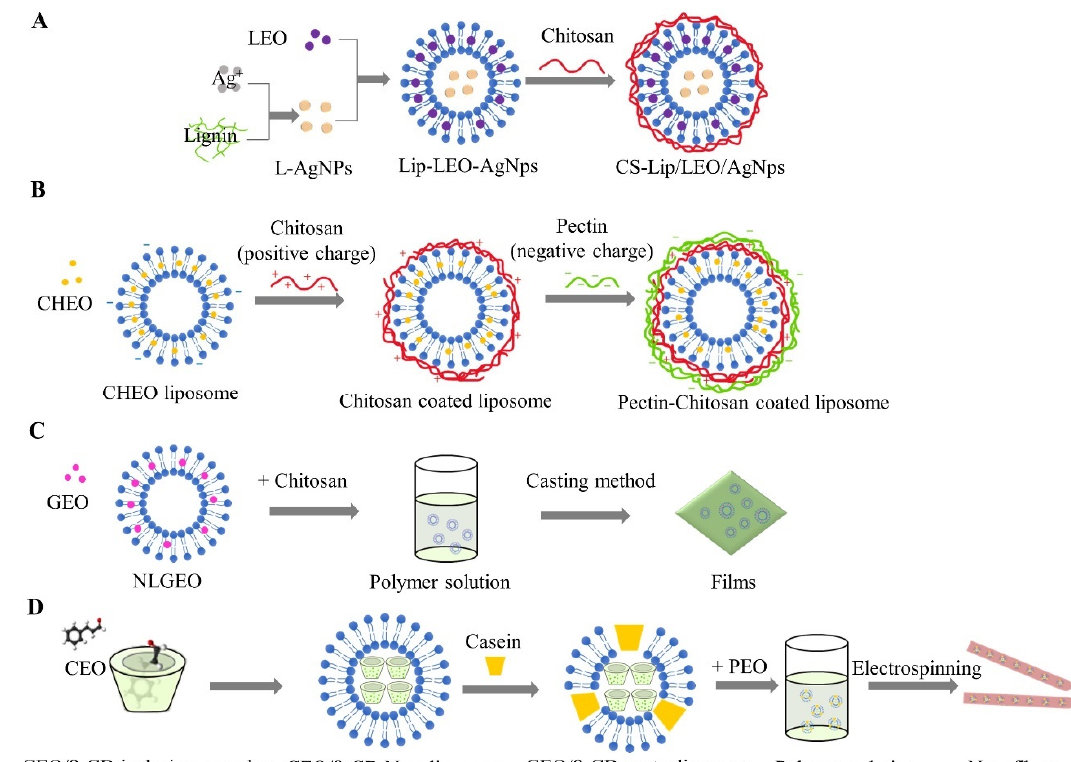
Figure 6. ( A ) Schematic preparation of CS-Lip/LEO/AgNPs for pork preservation. (Modified from Wu, et al. [36]). ( B ) Schematic preparation of pectin-chitosan coated liposomes ( C ) Schematic preparation of NLGEO incorporated into chitosan films. ( D ) Schematic of the preparation of CEO/ β -CD proteoliposomes incorporated into PEO nanofibers. (Modified from Lin, et al. [44]). LEO: laurel essential oil; AgNPs: silver nanoparticles; CS: chitosan; CHEO: chrysanthemum essential oil; GEO: garlic essential oil; NLGEO: garlic essential oil nanoliposomes; CEO: cinnamon essential oil; PEO: polyethylene oxide.